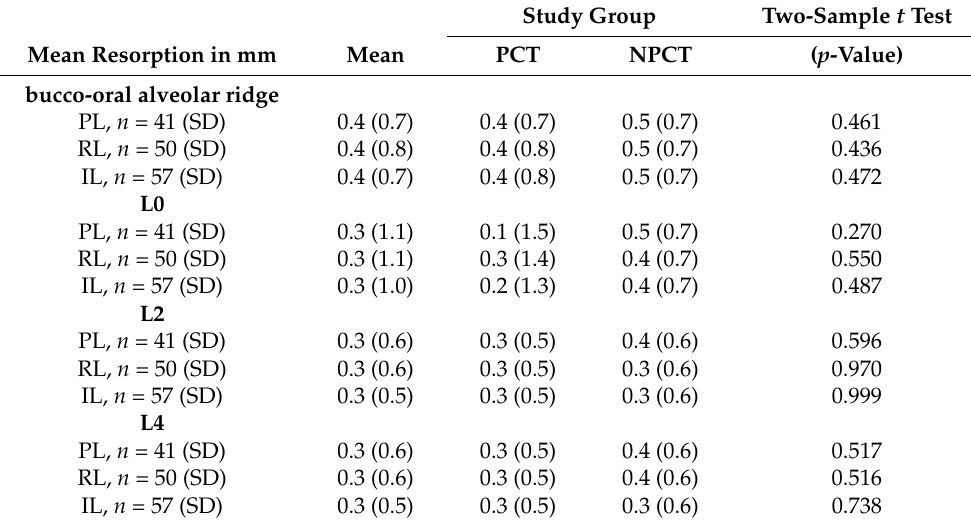
Table 4. Mean values of resorption from T1 to T2.